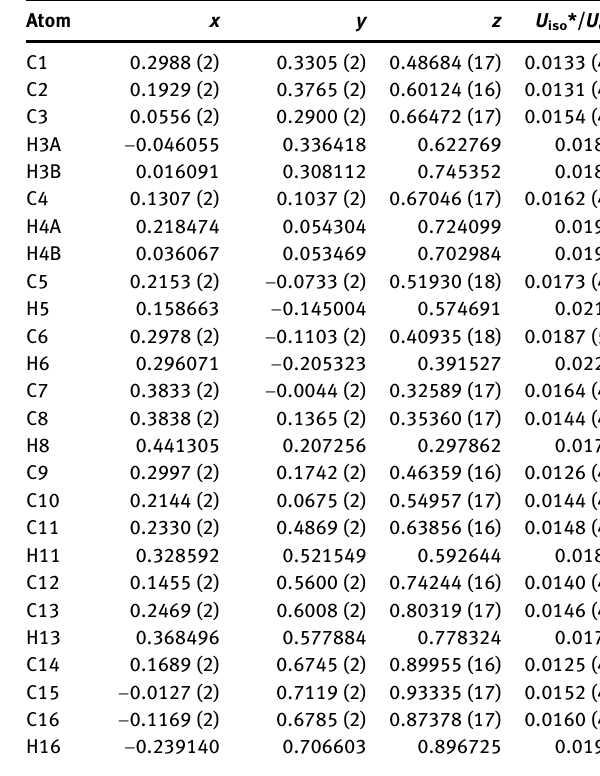
Table  : Fractional atomic coordinates and isotropic or